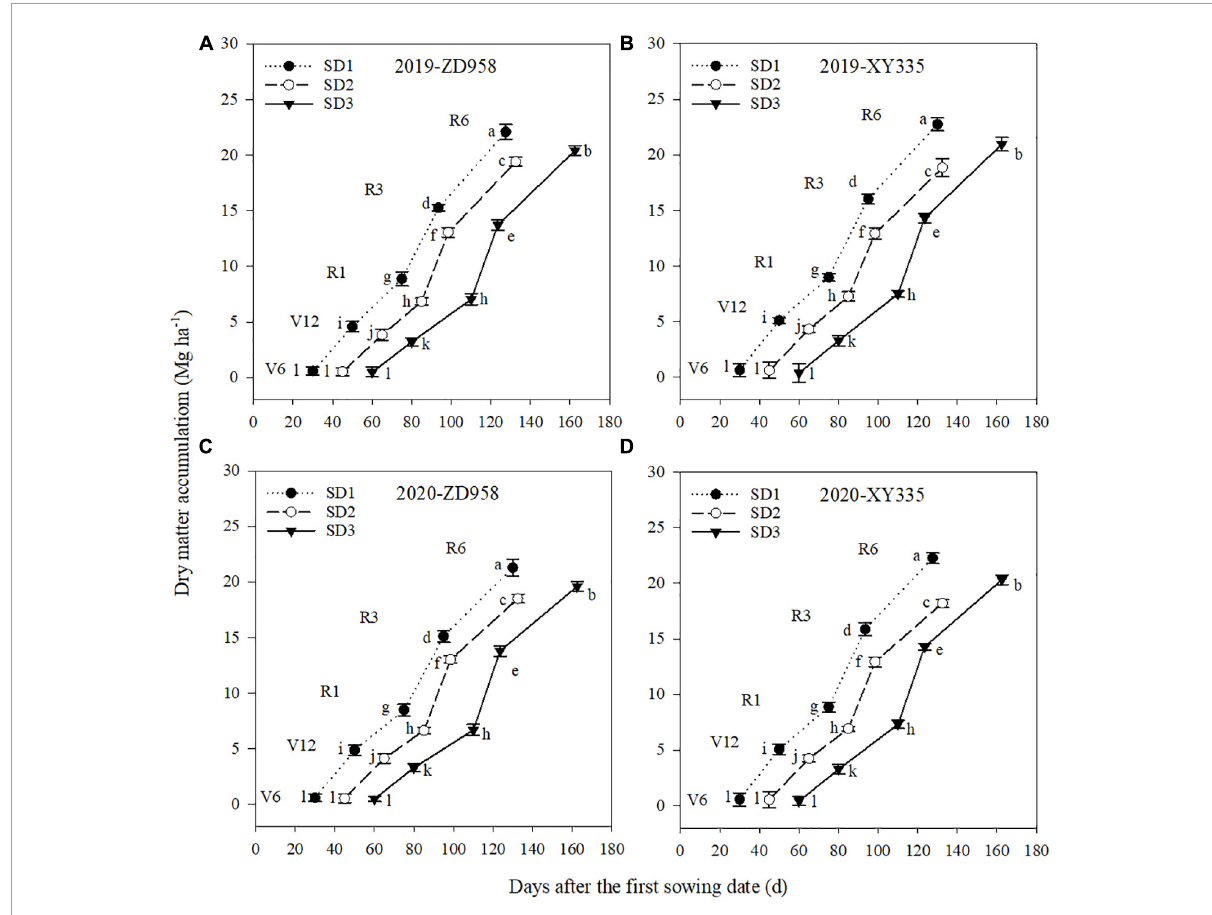
FIGURE3 Dry matter accumulation of maize for each growth stage under different sowing dates in 2019 (A,B) and 2020 (C,D)